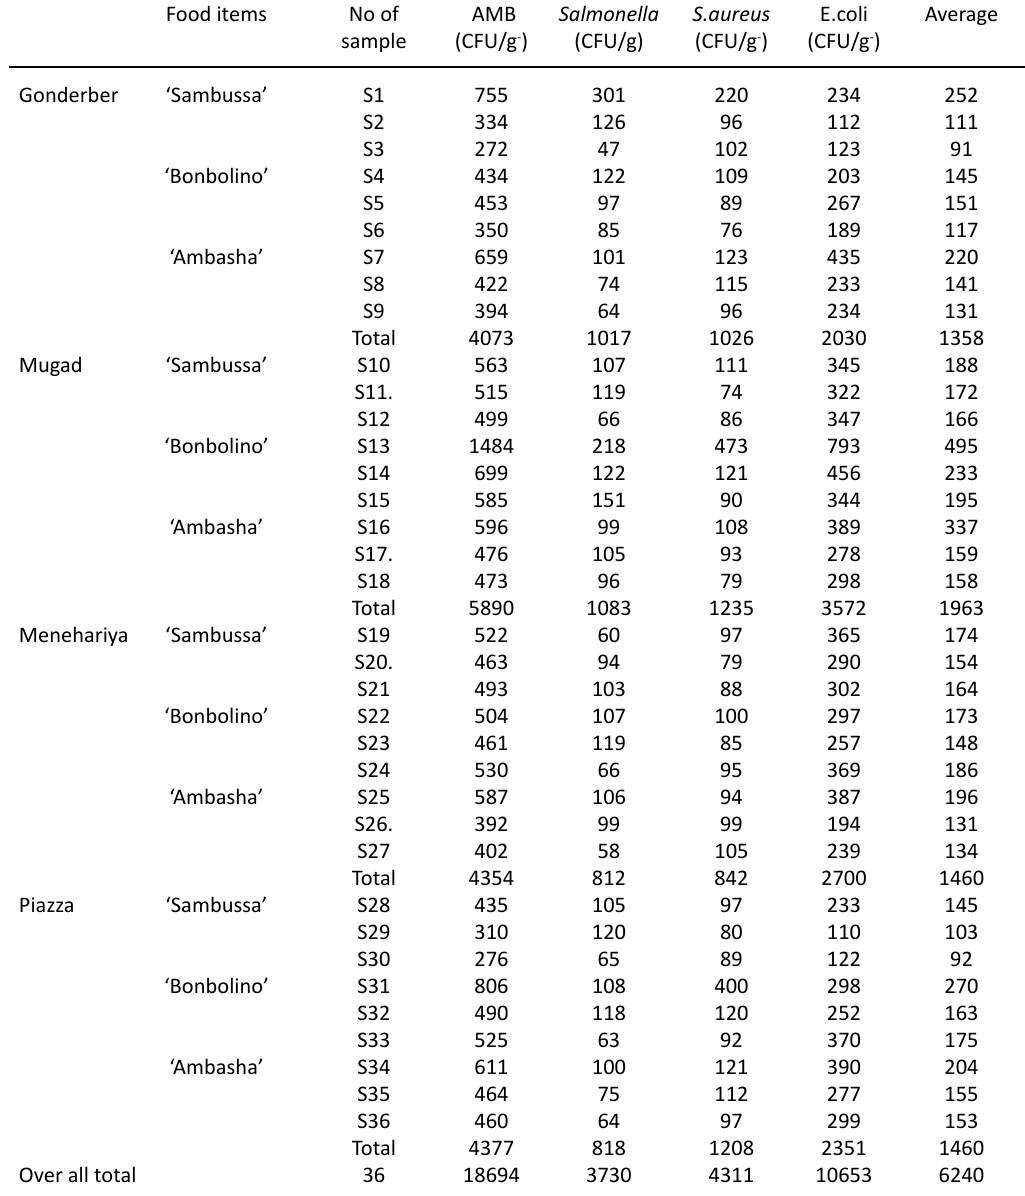
Table 3. Aerobic mesophilic bacteria and identified bacterial species in some selected food items in CFUg -1 . Food